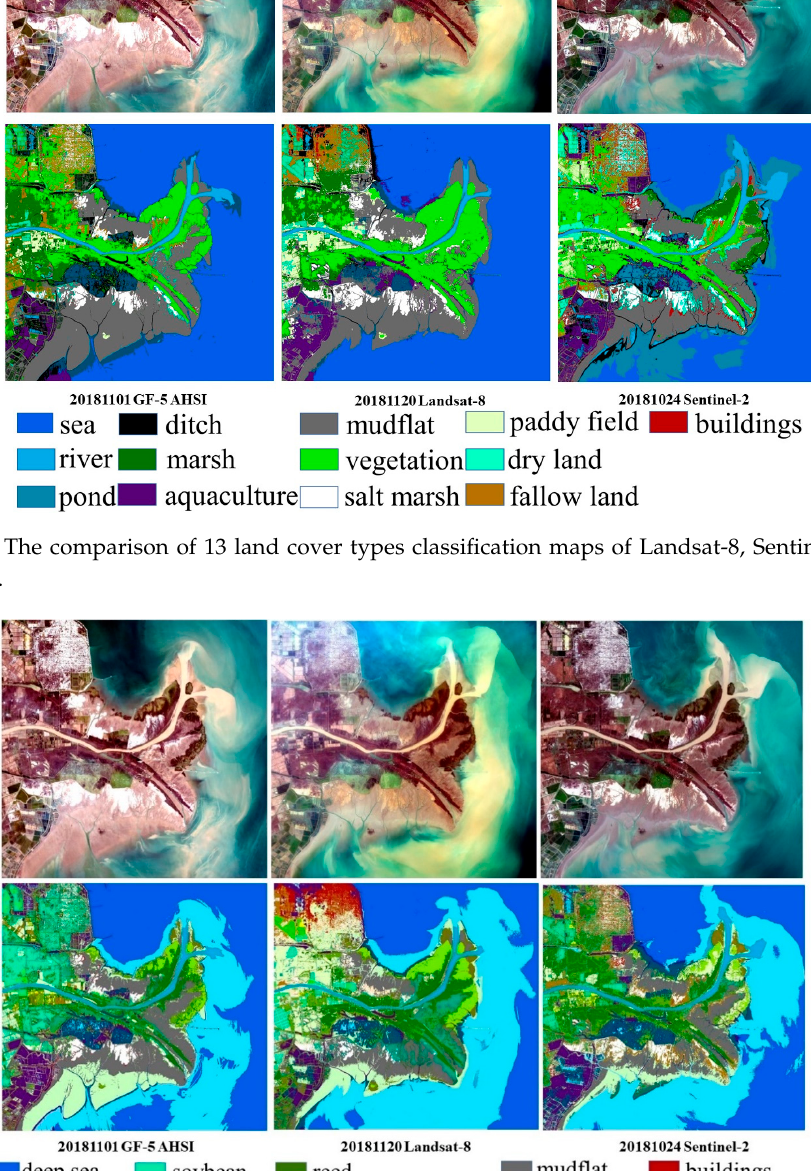
Figure 9. Classification maps of 21 land cover types on Landsat-8, Sentinel-2 and GF-5 data